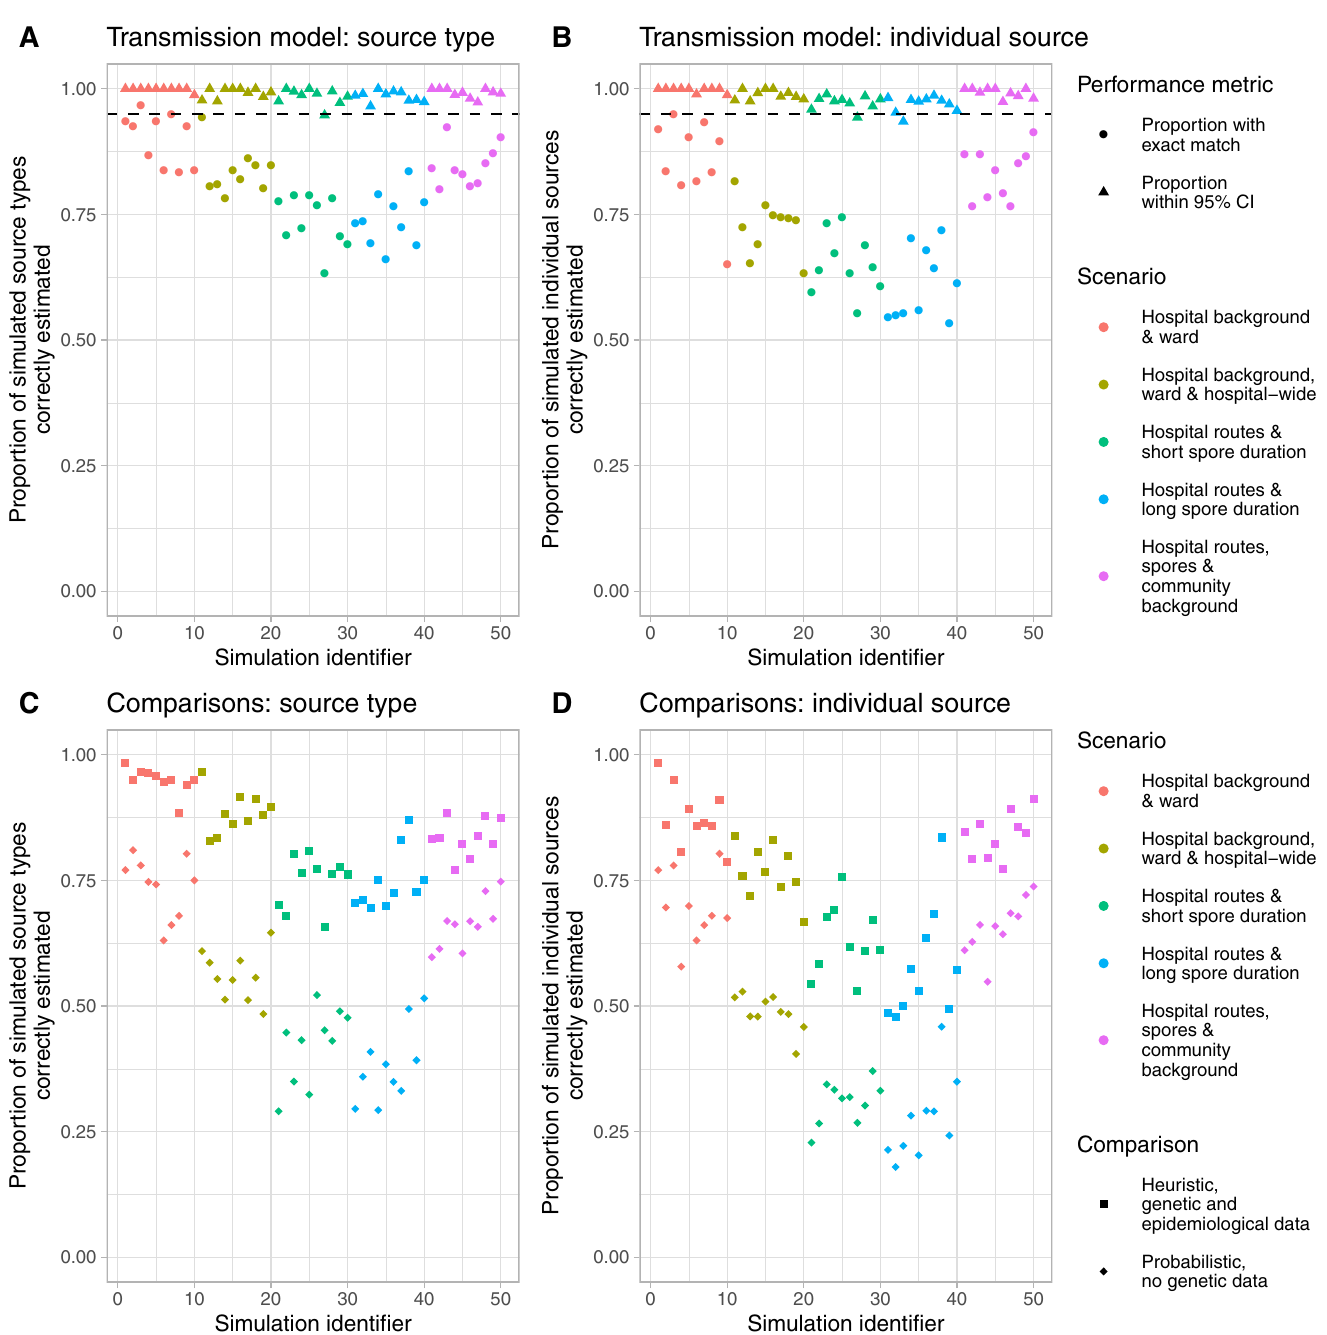
Fig 3. Source type and individual source attribution in simulated data. The left-hand columns (panels A and C) display the accuracy of inferences about the source type, i.e. distinguishing between hospital background, community background, ward, spore and hospital-wide transmission. The right-hand columns (panels B and D) display the accuracy of inferences about the specific patient source of each infection (for background source types this is an unknown source). Panels A and B display inferences from the full transmission model. Panels C and D display the accuracy of predictions running an inference model without using genetic data (circles) or based on a heuristic rule (squares). CI, credibility